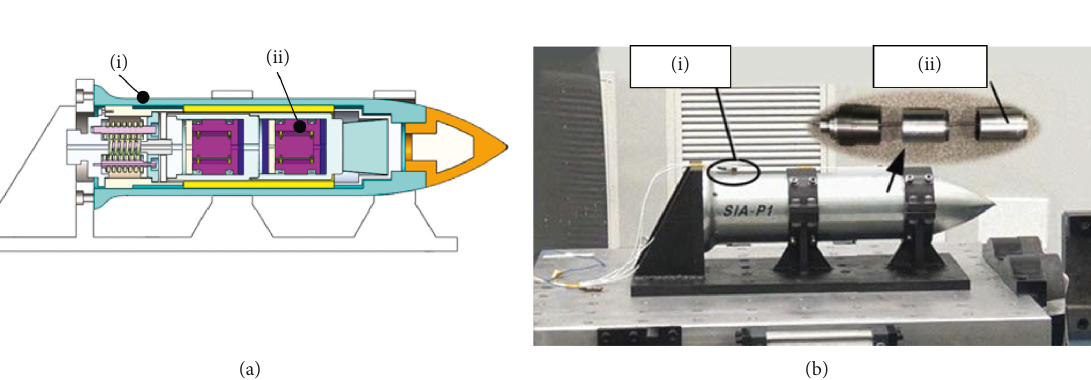
Figure 7: Distribution of sensor observation points. (a) Set position of the observation point; (b) observation point arrangement in the test. (i) Observation Point 1. (ii) Observation Point 2.